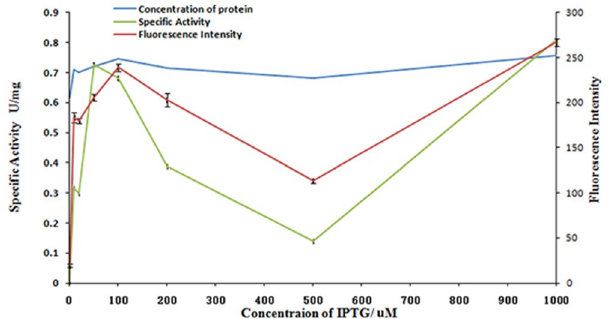
Figure 5. Optimazation of the extracellular secretion of sfGFP-MPH in E . coli . Blueline stands for theconcetration of extracellular secretion sfGFP-MPH;Green linestands for the special activity of extracellular secretion sfGFP-MPH; and Red line stands for the fluorescence intensity of extracellular secretion sfGFP-MPH.